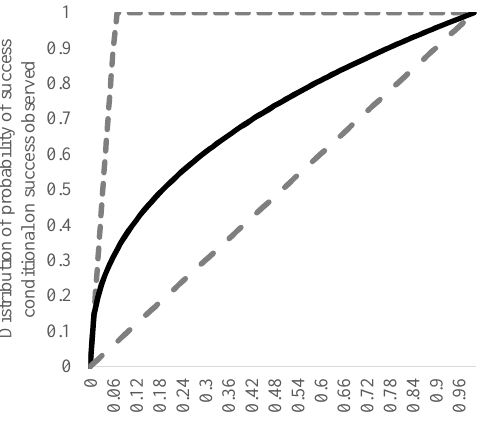
Source: own calculation based on: BCBS